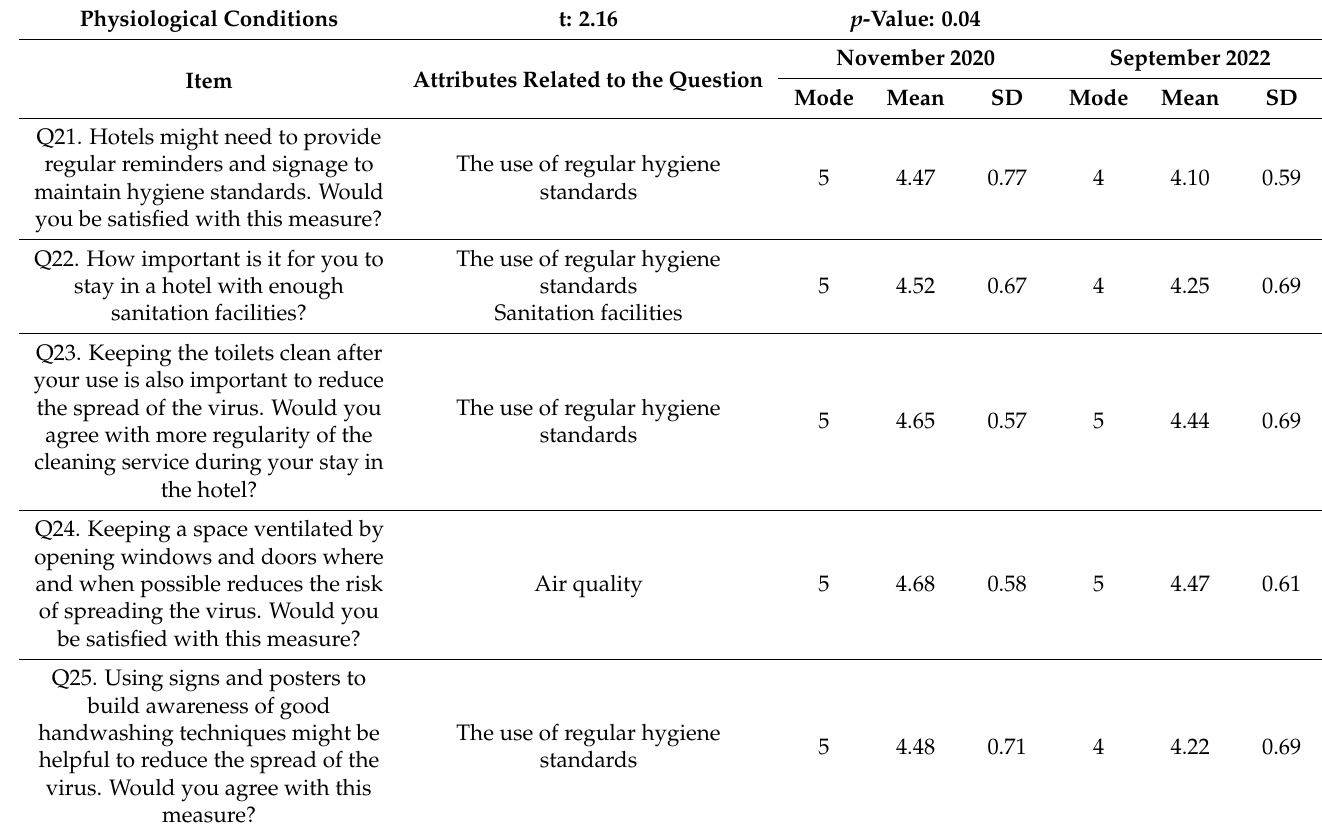
Table 6. Interval data analysis of the Physiological Conditions